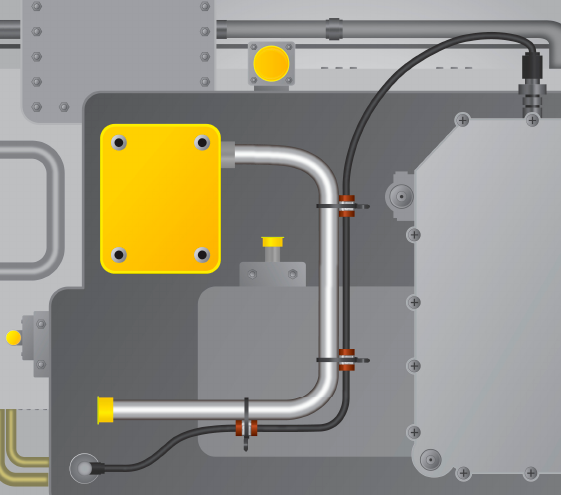
Figure 7. Installation of data cable and cap covers in their respective assembly locations.